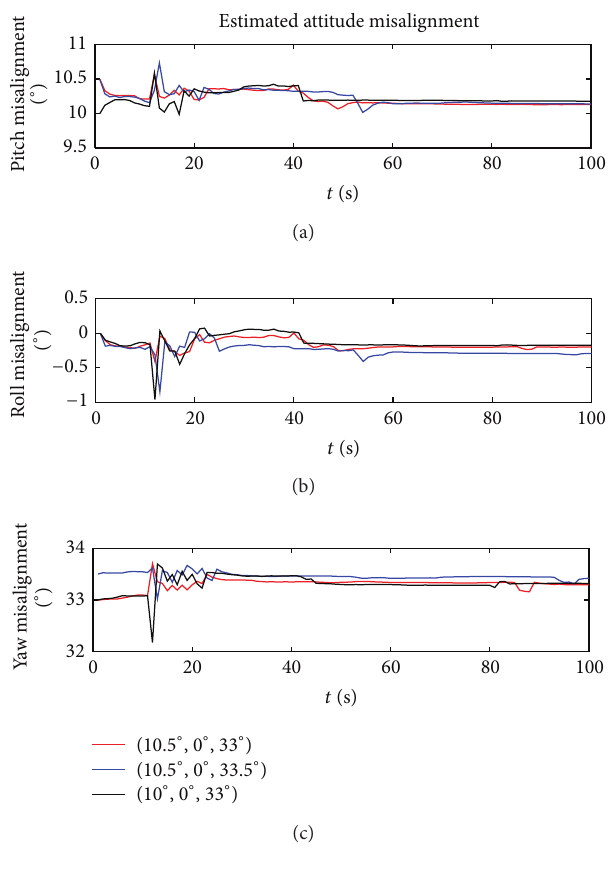
Figure 4: Curve of the vehicle